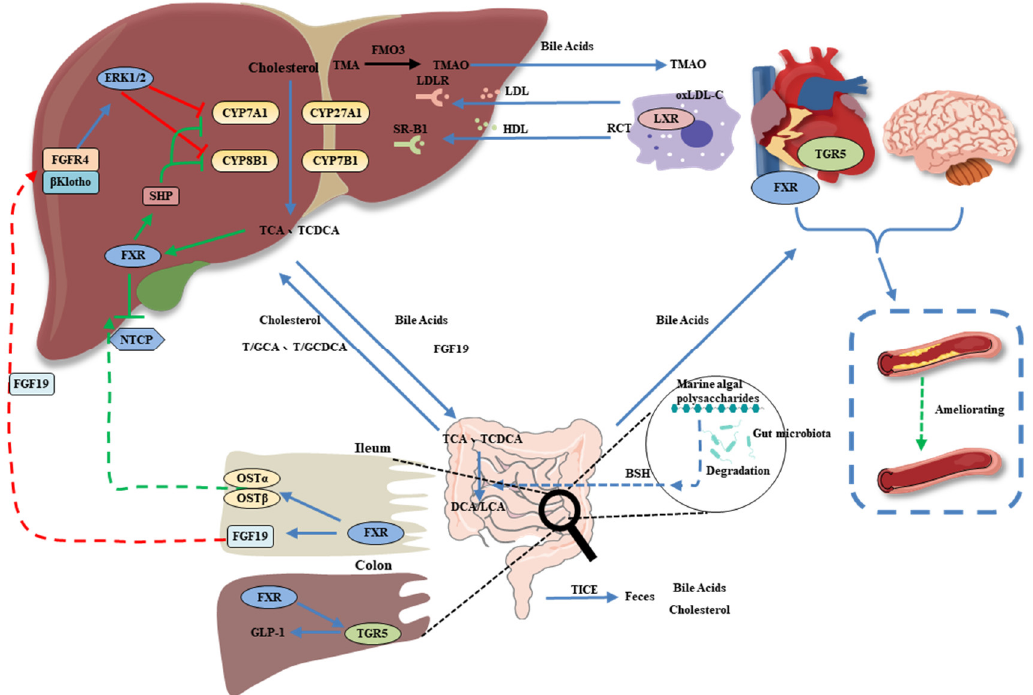
Figure 4. Effect of gut microbiota-derived bile acids on the CVD. Bile acids in turn impact the host physiology though interaction with FXR (farnesoid X receptor), LXR (liver X receptor), PXR (pregnane X receptor), and TGR5 (takeda G-protein–coupled receptor